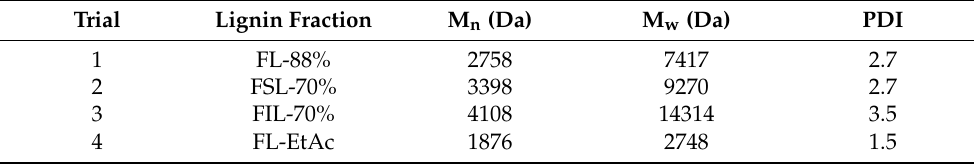
Table 2. Molecular weight analyses of acetylated lignin samples by